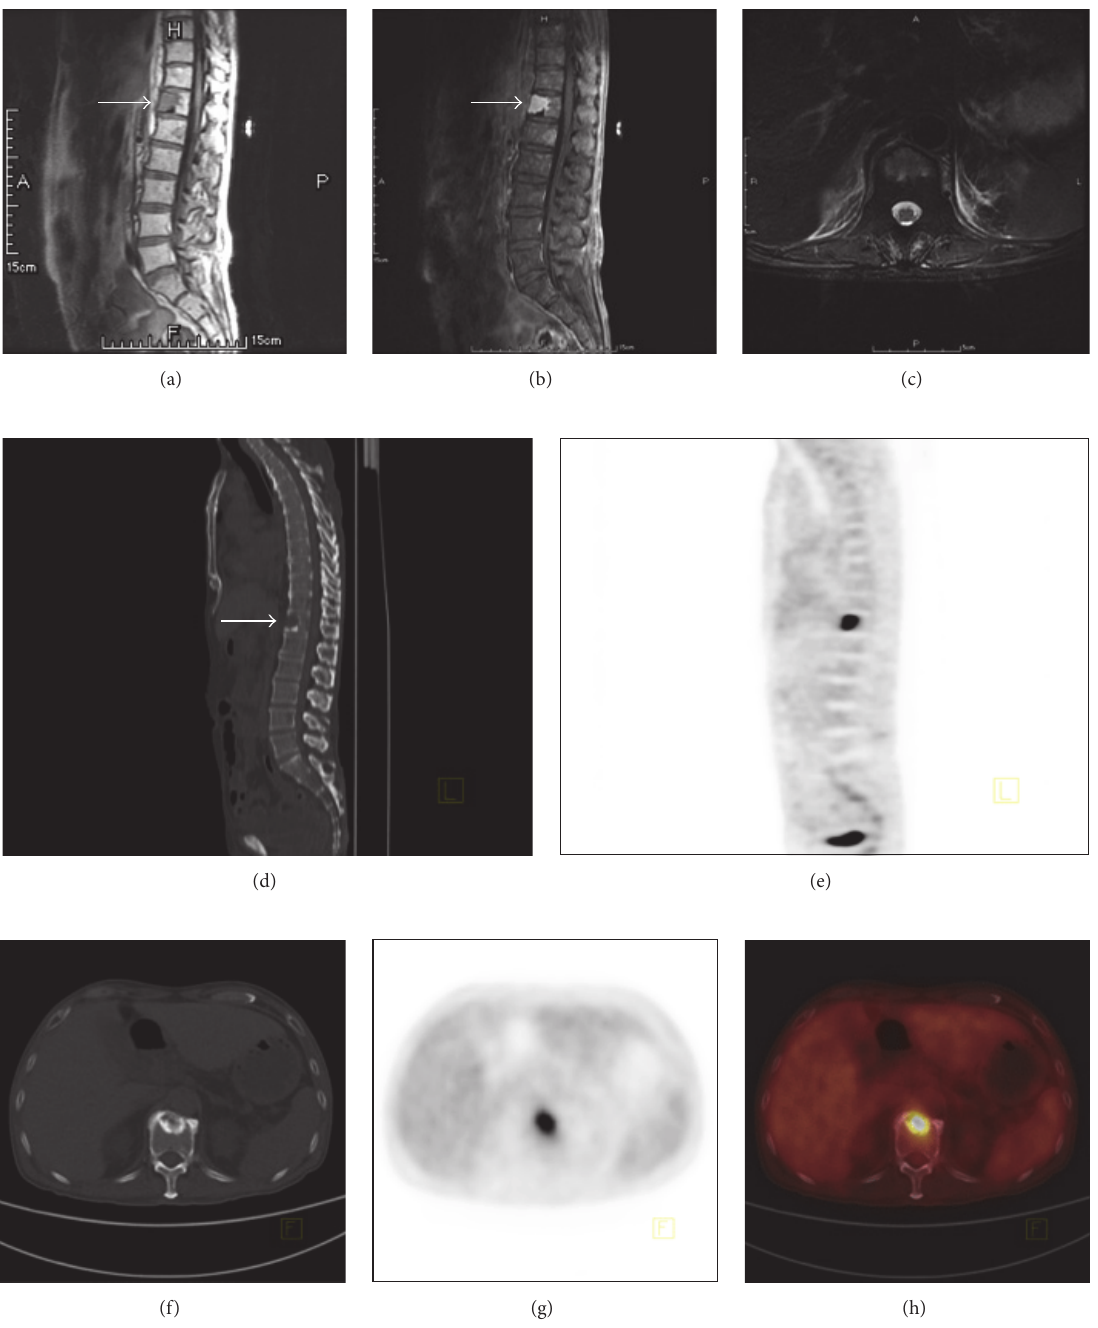
Figure 1: Images of the bone lesion detected by MRI and (18) F-FDG PET/CT. (a) ∼ (c): Short-tauinversion-recovery (STIR) sequence in MRI shows a bone lesion in T12 vertebra, with T1-hypointense and T2-hyperintense signal. (a) Sagittal TI STIR image. (b) Sagittal T2 STIR image. (c) Transaxial T2 STIR image. (d) ∼ (h): (18) F-FDG PET/CT image shows an osteosclerotic lesion, with hypermetabolism in T12 vertebra. (d) Sagittal CT image. (e) Sagittal PET image. (f) Transaxial CT image with a significant sclerotic ring around the bone lesion. (g) Transaxial PET image with an average SUV value of 12.4. (h) Fused PET/CT image.